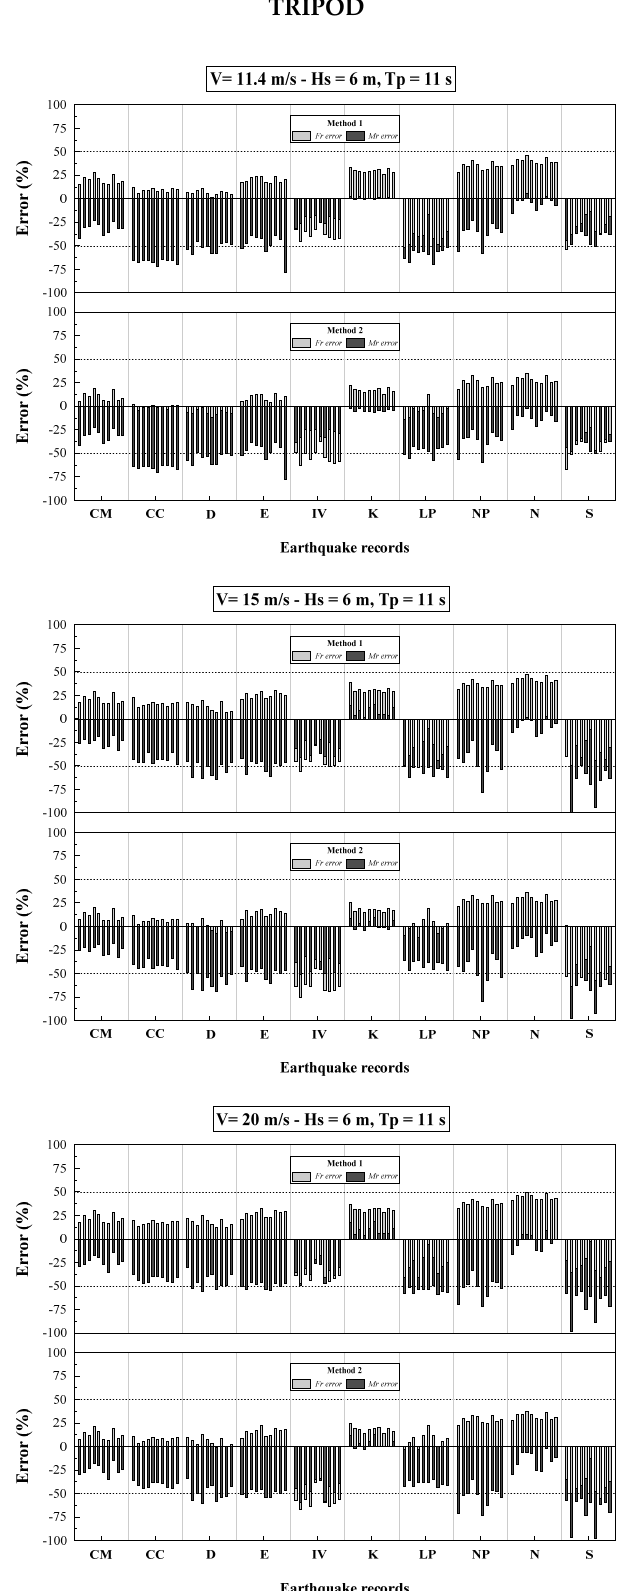
Figure 7. Tripod: Tower base errors (18)–(19) obtained by Methods 1 ‐ 2 for sea state parameters H s = 6 m, T p = 11 s, all wind velocities at hub and earthquake records listed in Table 3.